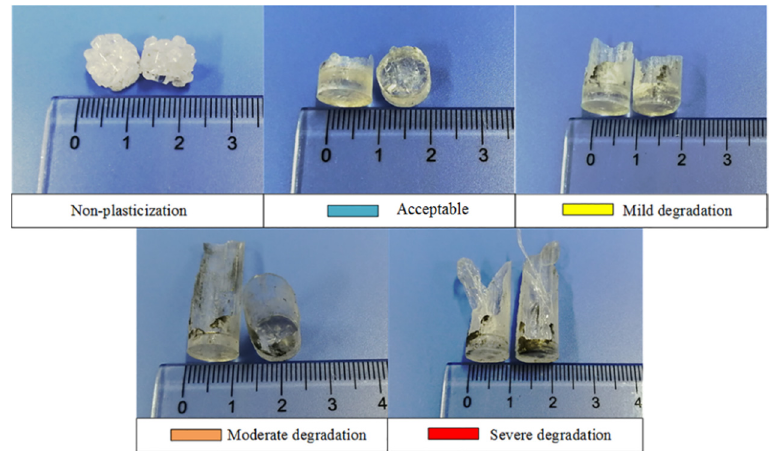
Figure 5. Representative samples obtained under Mode 1.